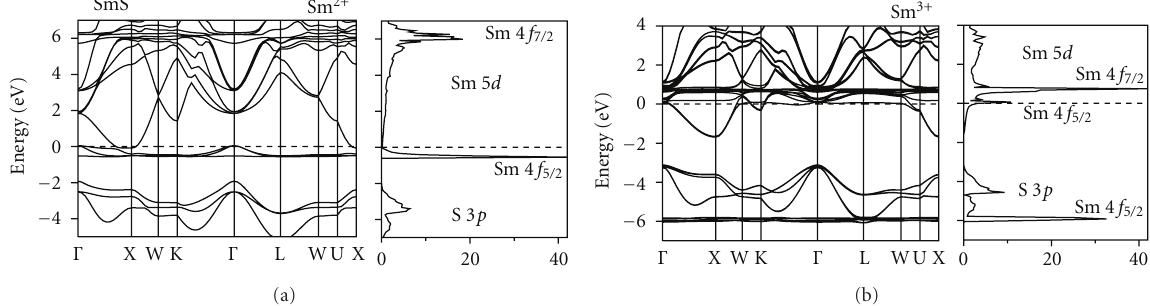
Figure 51: Self-consistent fully relativistic, spin-polarized energy band structure and total DOS (in states/(unit cell eV)) calculated for SmS with the LSDA+ U approximation for divalent and trivalent Sm atoms